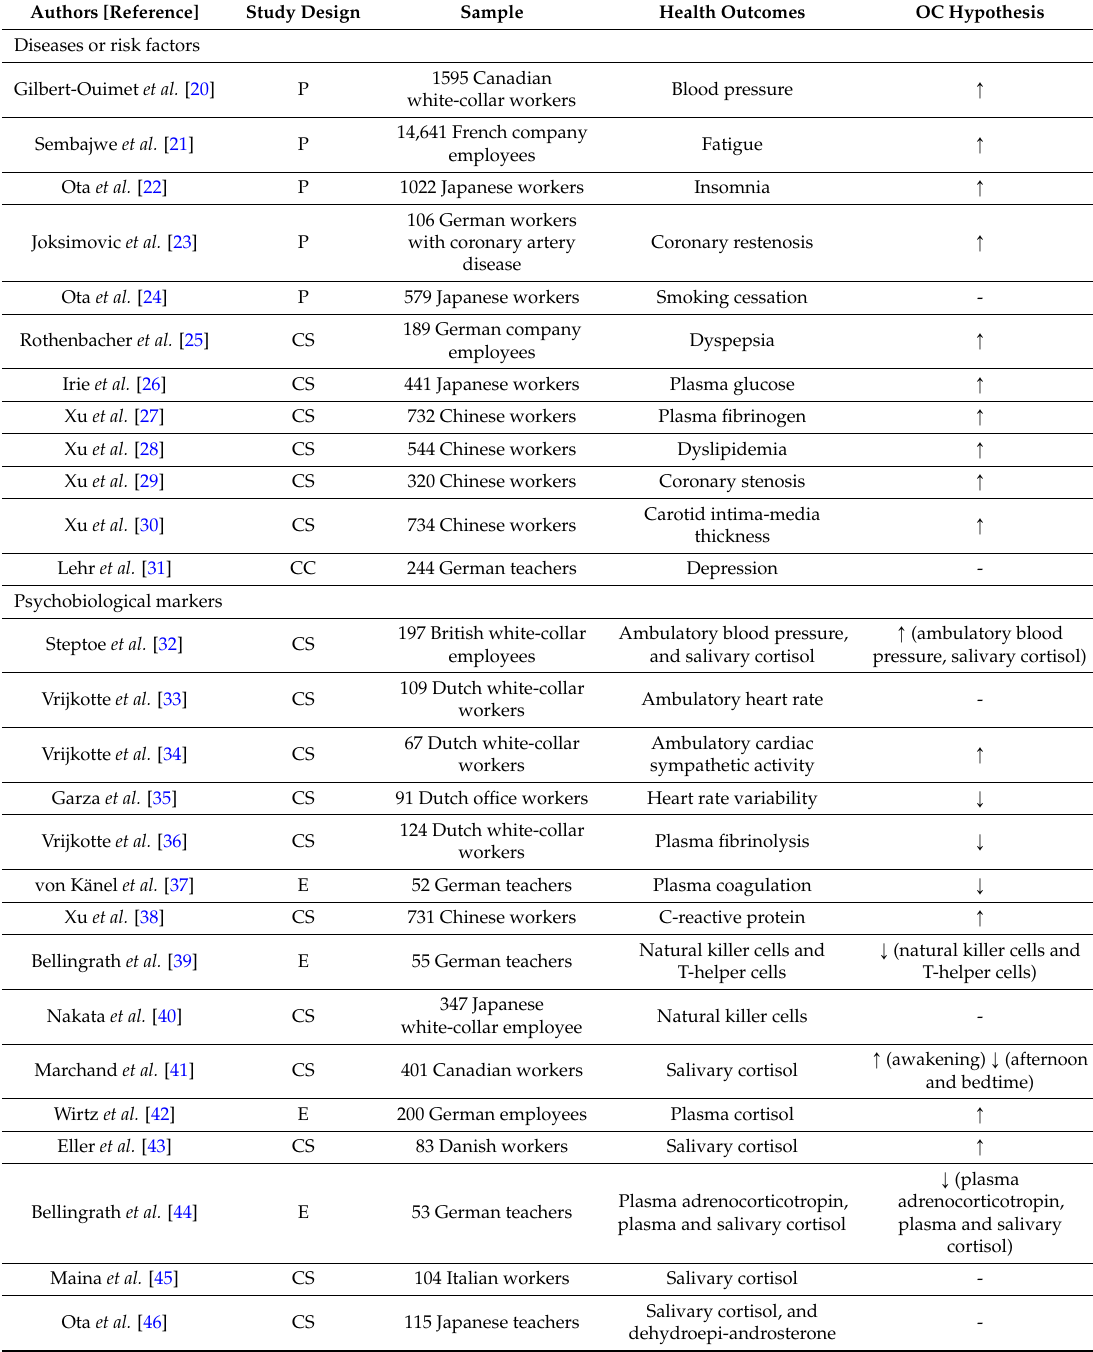
Table 1. Summary of effects of over-commitment on